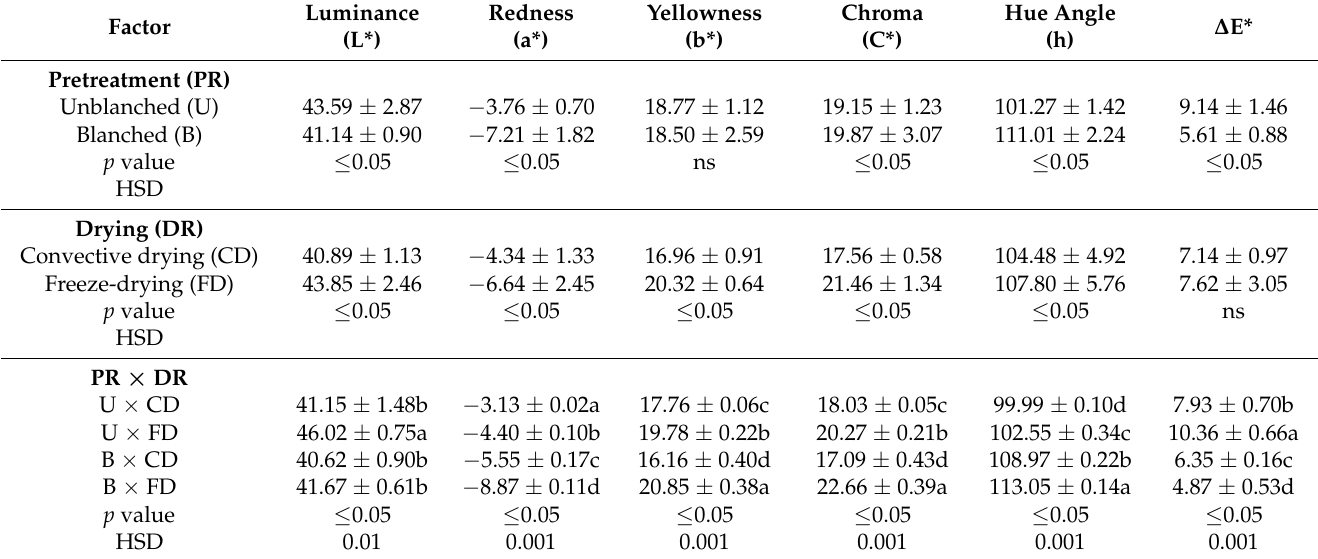
Table 3. The interaction effect of pretreatment (PR) and drying (DR) factors on colorimetric parameters of the nettle powders obtained from different treatments. Data are mean ± standard deviation of the mean. Mean values belonging to the same factor without common letters are statistically different according to HSD ( p ≤